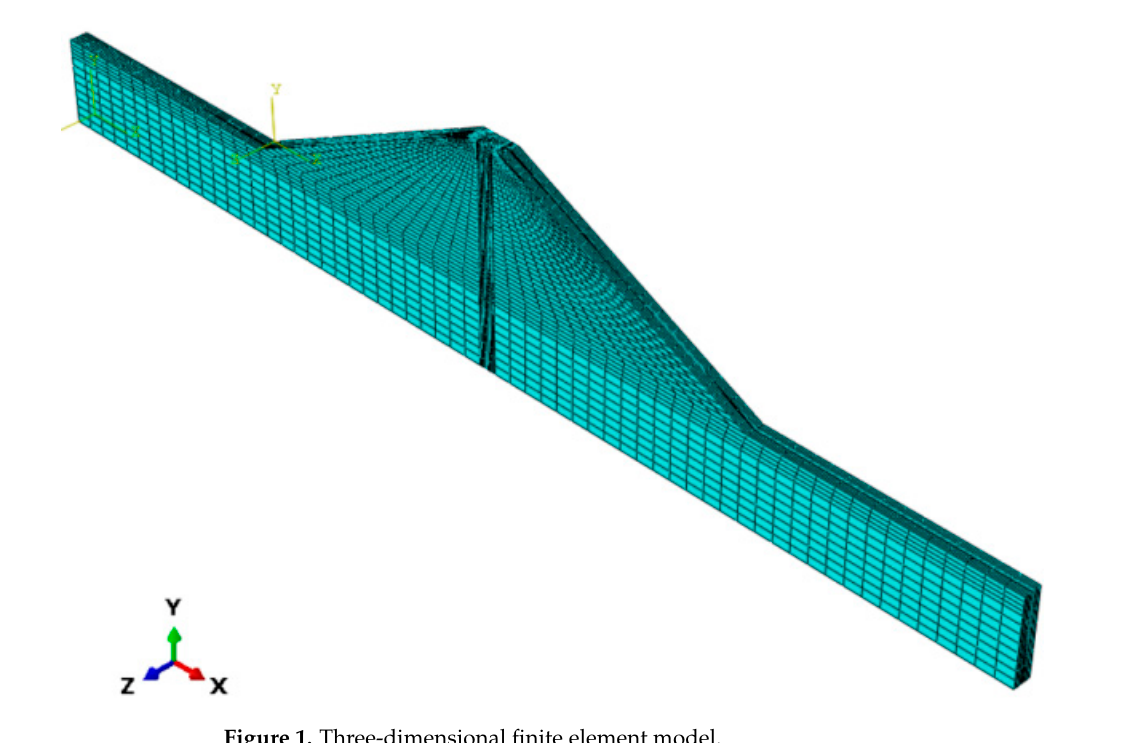
Figure 1. Three-dimensional finite element model. Table 1. Material parameters of anti-seepage wall and soil body.